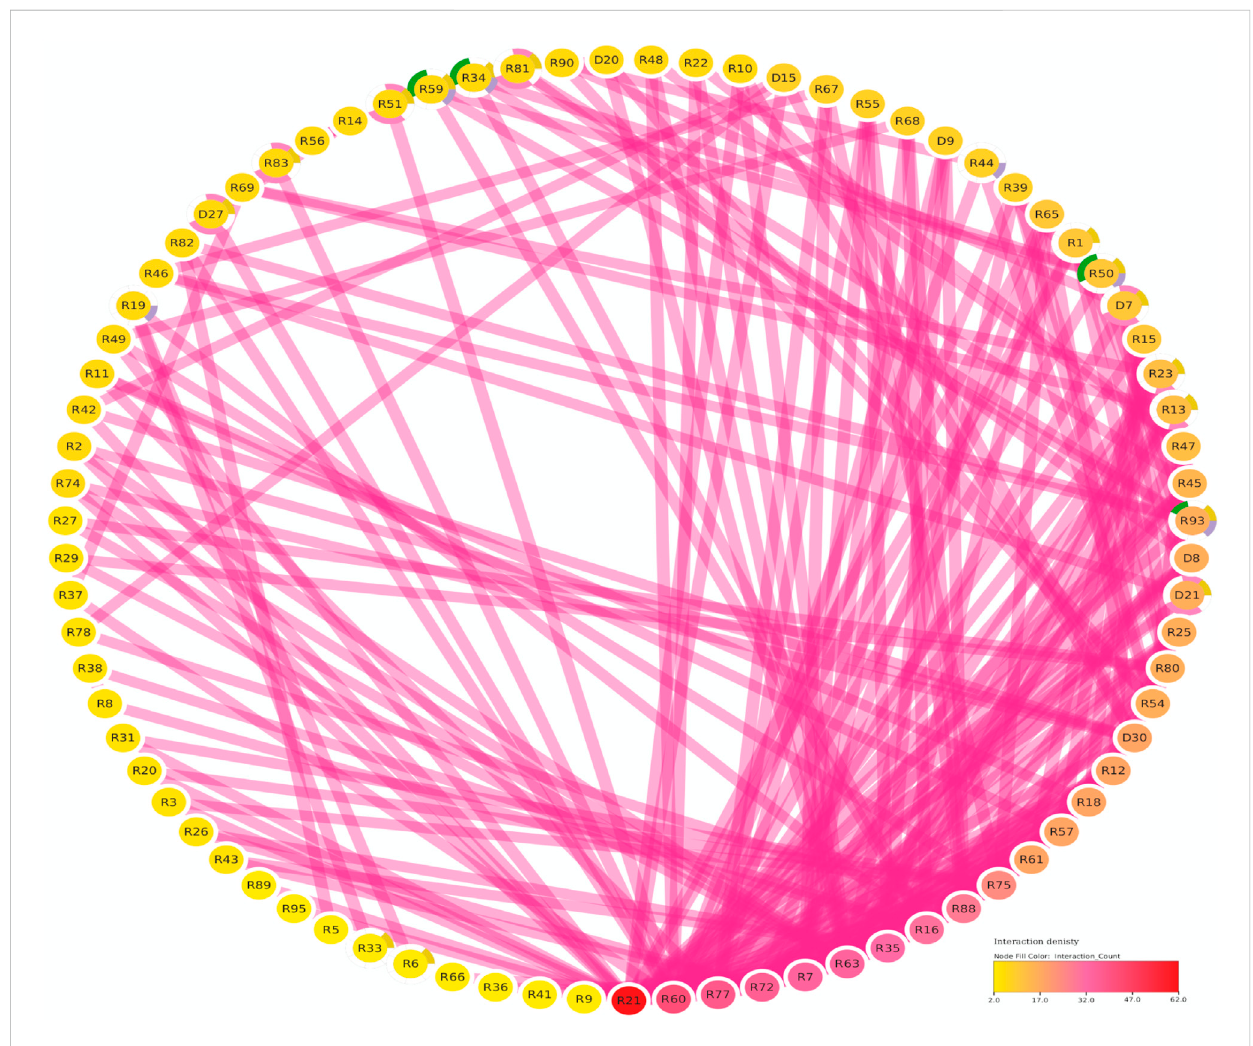
FIGURE 4 The Functional Regulatory Network of Grass Pea (LsbHLH) Proteins. The fi gure presents a visual representation of the protein-protein interactions among 79 grass pea LsbHLH proteins, predicted using the STRING database and visualized using Cytoscape software. The Interaction Count panel displays the number of interactions each gene has, with R21 being the most interactive gene. Gene names are abbreviated by removing the “ LsbHLH ” pre fi x for clarity. The color-coding of the nodes provides insights into the biological functions of the genes. Green borders indicate involvement in stomatallineageprogression; yellowindicatesinvolvementinembryonicdevelopment;blueindicatesinvolvementinplantepidermisdevelopment;pink indicates involvement in fl ower